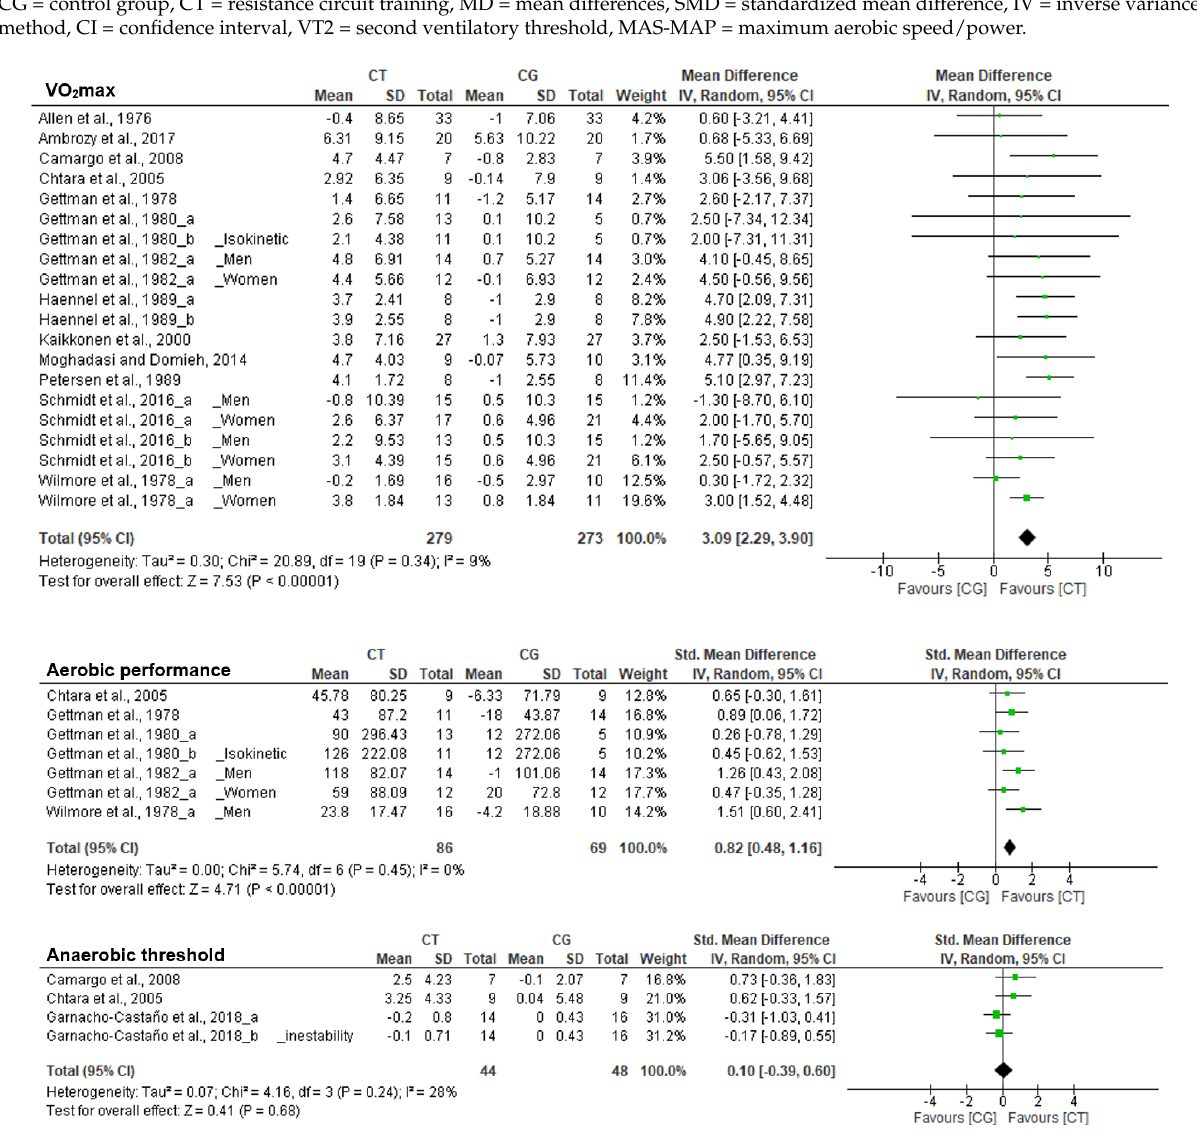
Figure 3. Forest plot showing the results of a random effects meta-analysis for resistance circuit training (CT) compared to control group (CG) on aerobic performance.